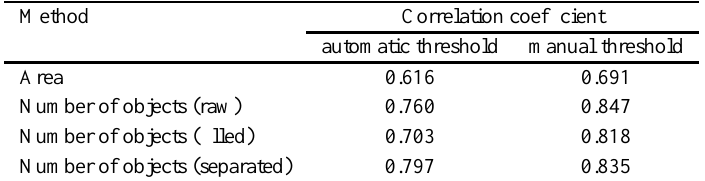
Correlation to manual object counting for different stages of the proposed method, using automatic and manual thresholding